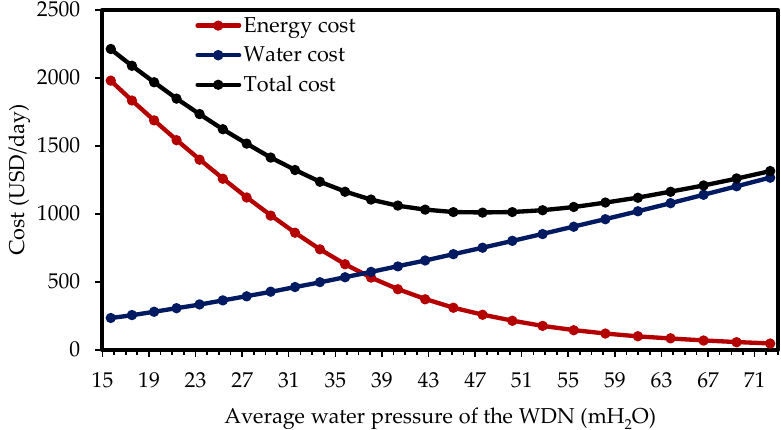
Figure 6. Model results for calculating the optimized average pressure of the network. The determined optimum pressure level is highly dependent on local conditions. The degradation of water pipes results in a reduction of the optimum pressure of a WDN.